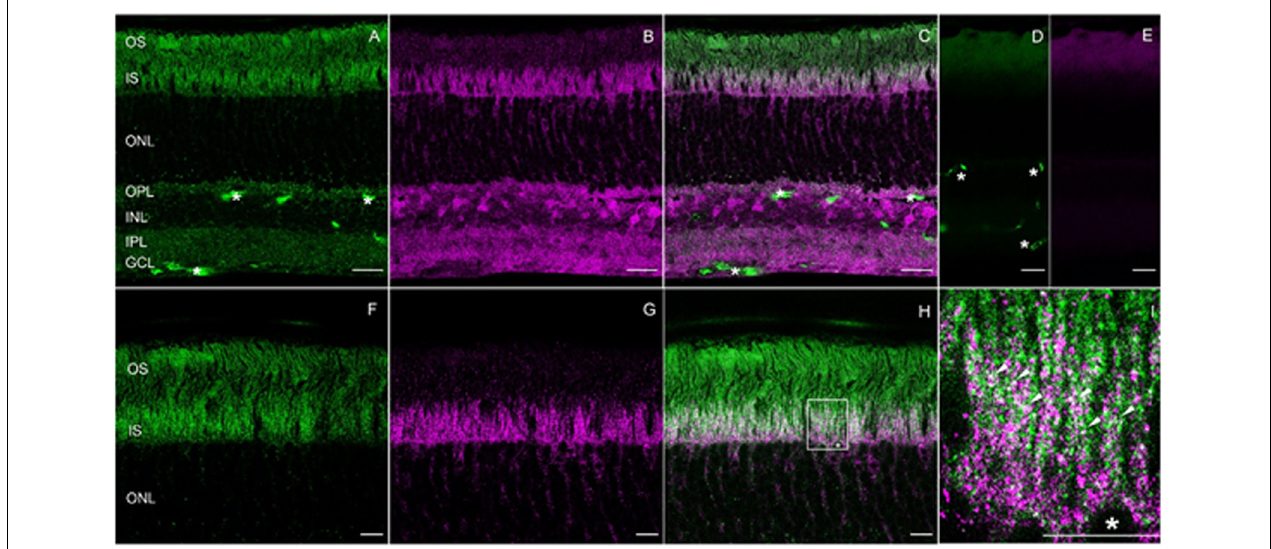
FIGURE 5 | Expression and co-localization of RD3 and GUK in wild-type mouse retina. Cryosections of mice retinae were stained for RD3 (green, A,C,F,H,I ) and GUK (magenta, B,C,G–I ). The overlays (C,H,I) reveal partial co-localization of the two proteins in the inner segments of photoreceptors, particularly visible at higher magnification ( I , arrow heads). For orientation a photoreceptor soma is labeled by an asterisk ( ∗ , H,I ). Control stainings with secondary antibodies are shown in (D,E) . Unspecific staining of blood vessels is indicated ( ∗ in A,C,D ). (A–E) Maximum projections of confocal scans (12 optical sections, 0.3 µ m thick). (F–H) Single